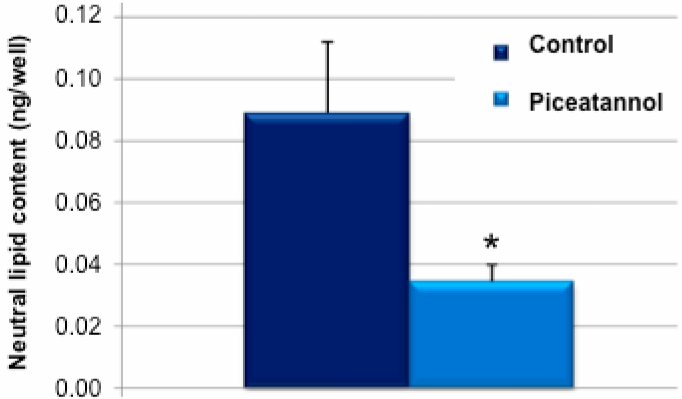
Figure 5. Inhibition by piceatannol of lipid accumulation in human adipocytes. Each column represents the mean ± SEM of a total of 48 determinations made on a total of four hMSC lines. Difference between 50 µ M piceatannol and control condition (DMSO vehicle) at * p < 0.05 by Student’s t